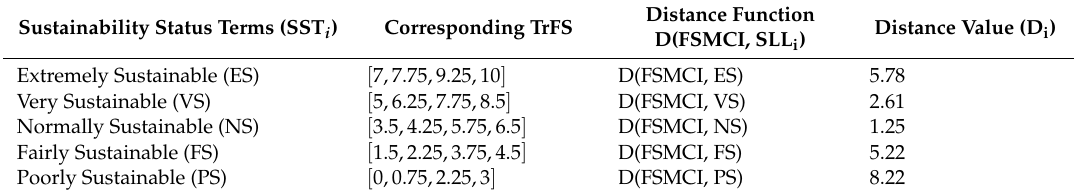
Table 10. The obtained distances and determination of the current